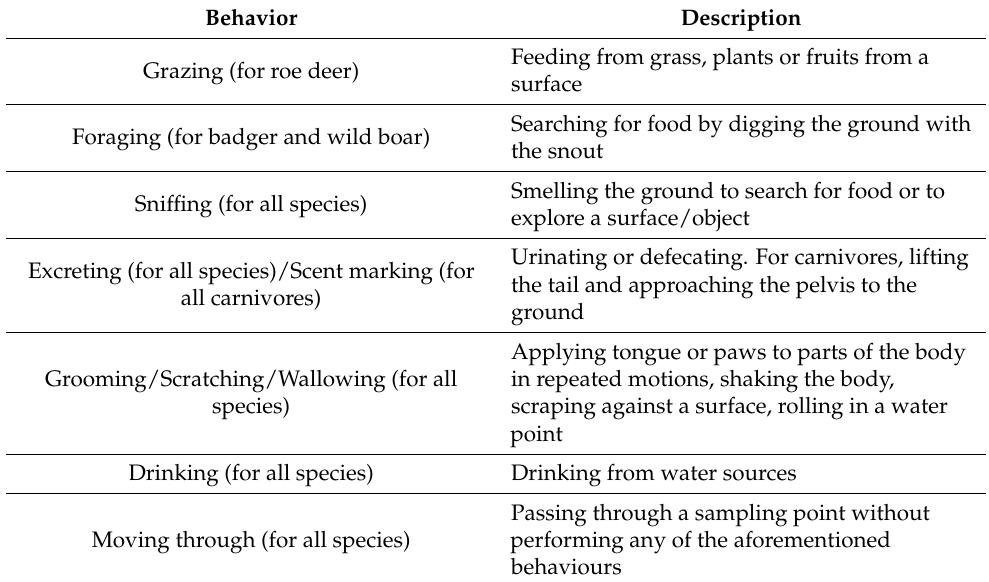
Table 2. Description of behaviours observed among wild